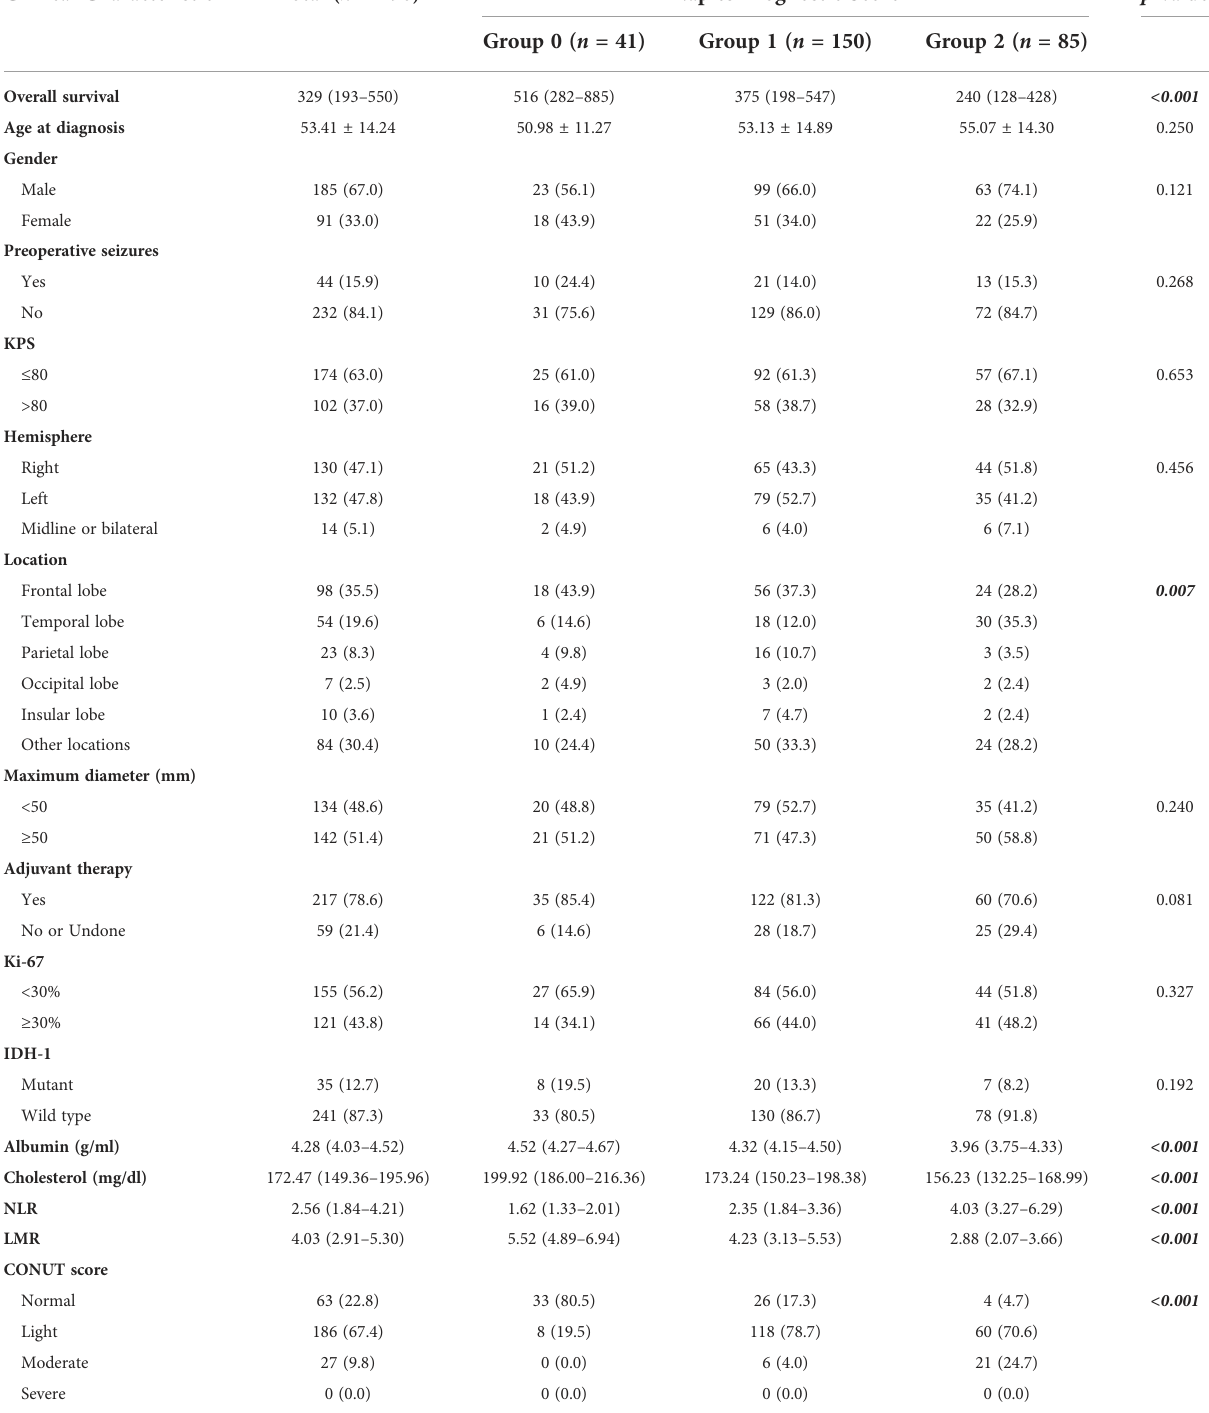
TABLE 1 Baseline clinical characteristics of glioblastoma patients in the current